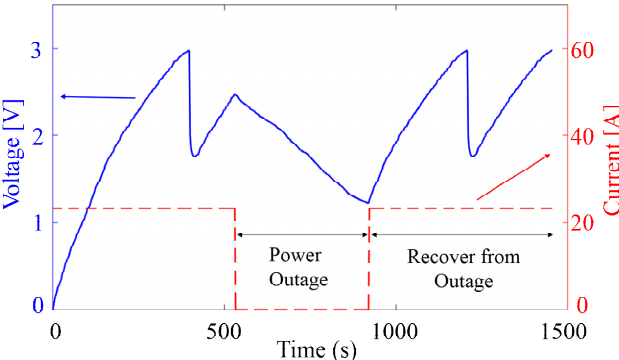
Figure 13 . Charging/discharging behavior of the storage capacitor for WSN operations when a power outage occurs. Tested with EH2 when the current in the wire is 23.3 A before/after the outage. Successful completion of data transmission demonstrates the system’s automatic recovering from outages.